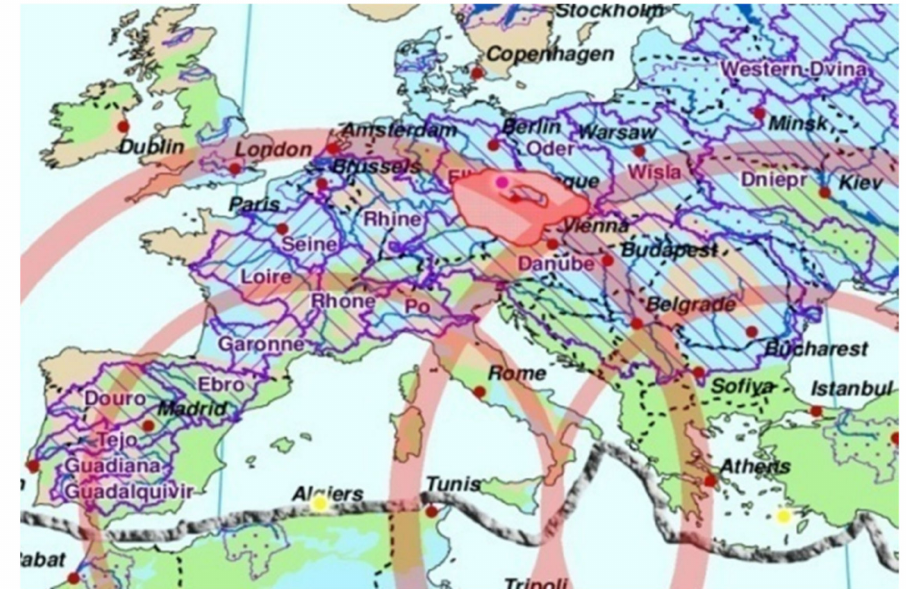
Figure 22. Flooding in Europe–05-06, 2013 (both without and with designation): yellow circles– earthquake epicenters; purple circles–fixed location of the flood areas; transparent red circles– schematic representation of seismic wave propagation; gray curves–lithospheric plate boundaries; areas with cranial border–potentially dangerous zones (marked by red color areas) for catastrophic floods based on seismic factor analysis in association with the river basin